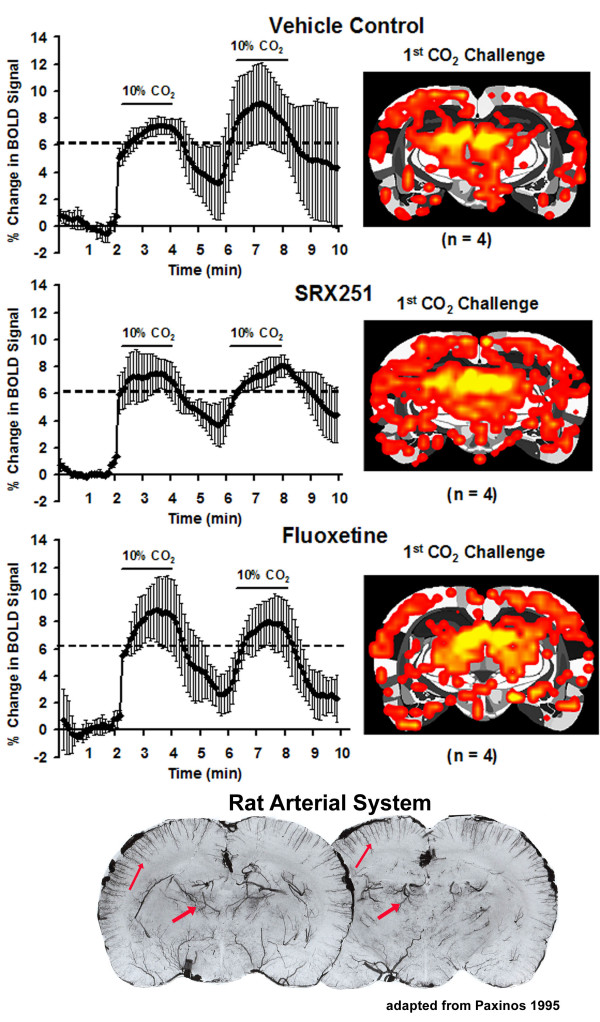
Controlling for vascular reactivity. Shown are time course data depicting the change in BOLD signal (mean + SD) in response to a 2 min challenge with 10% carbon dioxide (CO2). The average activation map for each experimental condition (vehicle, SRX251, fluoxetine) is shown overlayed onto the same coronal section of the segmented rat atlas. The solid horizontal line denotes the approximate maximal BOLD signal change under each experimental condition. The photomicrographs show coronal sections of the rat brain following intravascular injection of a black latex for delineating cerebral arterial blood vessels (adapted from [185]). Note the high density of vessels in the dorsal thalamus and cortex (arrows).